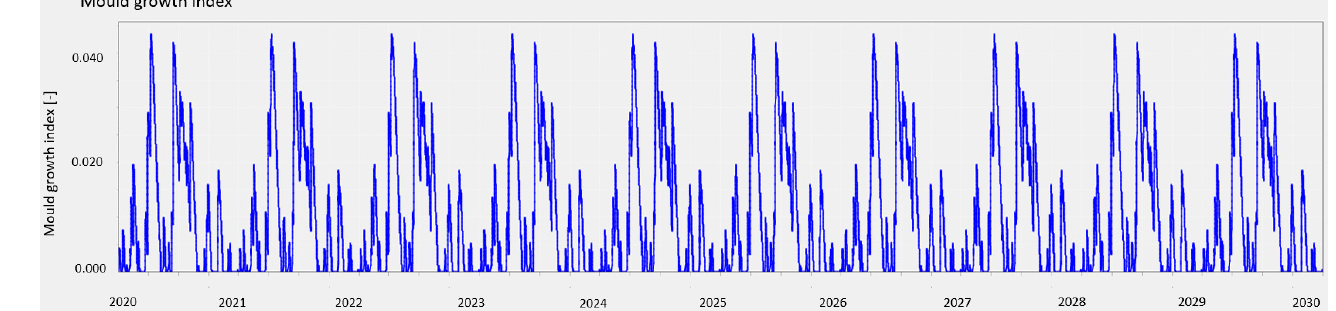
Figure 11. Graph showing mould growth results and mould index within the clay masonry layer of the 7-star clay masonry veneer wall with a vapour-permeable membrane—north orientation.